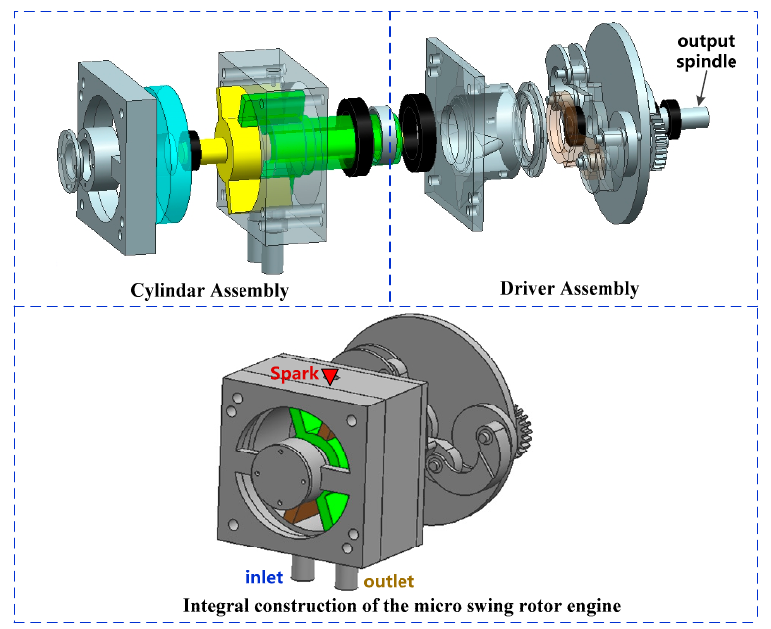
Figure 1. Composition of the overall structure for the micro swing rotor engine (MSRE).